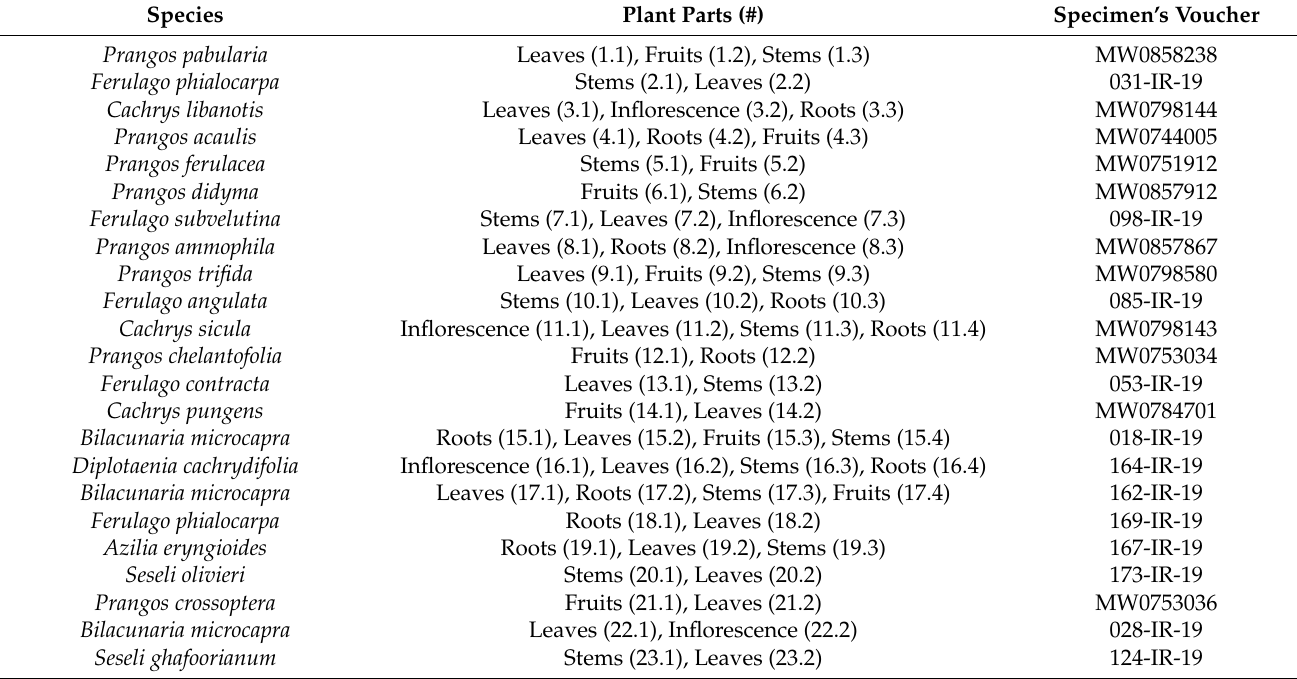
Table 1. List of investigated specimens: 62 plant parts from 20 different species